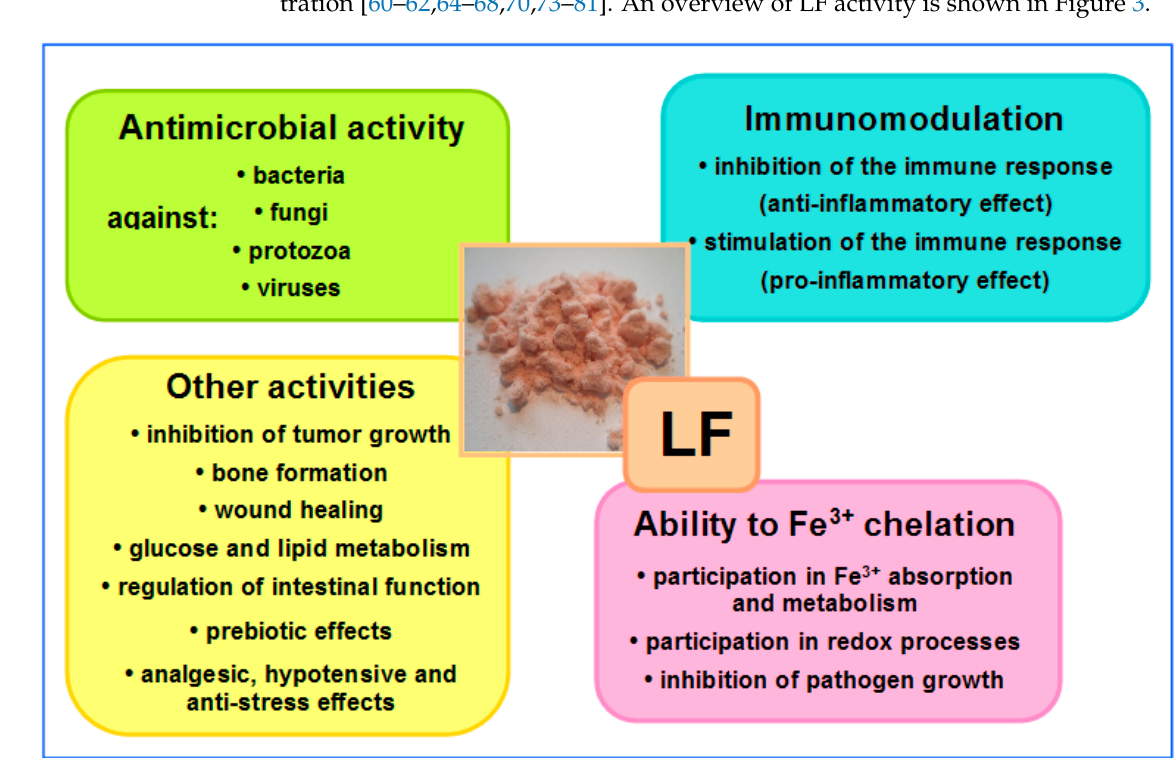
Figure 3. Overview of LF activities. In the central part, native LF isolated from bovine milk—salmon-colored powder (the intensity of the color depends on the degree of iron saturation—the more iron bound to the LF molecules, the darker the color of the powder); native LF is saturated at around 10% (photo by J. Artym).